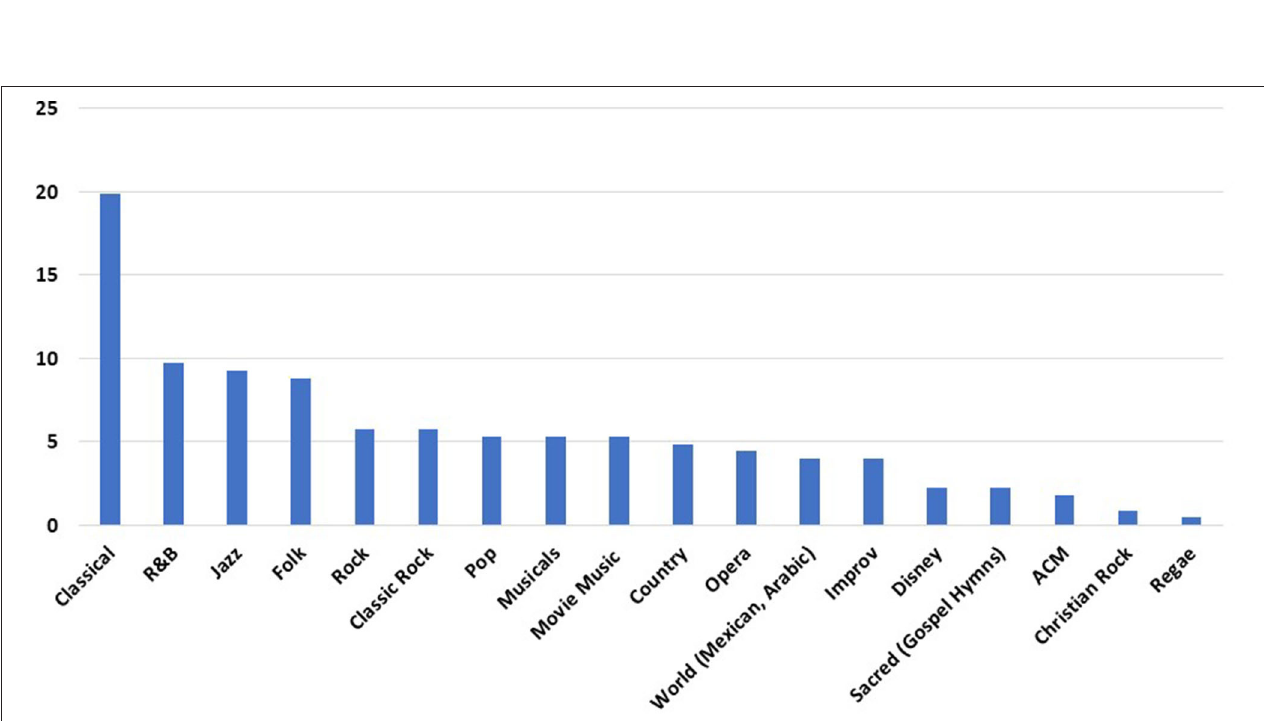
FIGURE 3 | Musical genres used for telemusic intervention. Classical music, Rhythm and Blues (R&B), and Jazz were the top three categories requested by patients. Y-axis depicts how many times each genre was played during 87 sessions of telemusic interventions. ACM, Adult Contemporary Music; Improv, Improvisatory.